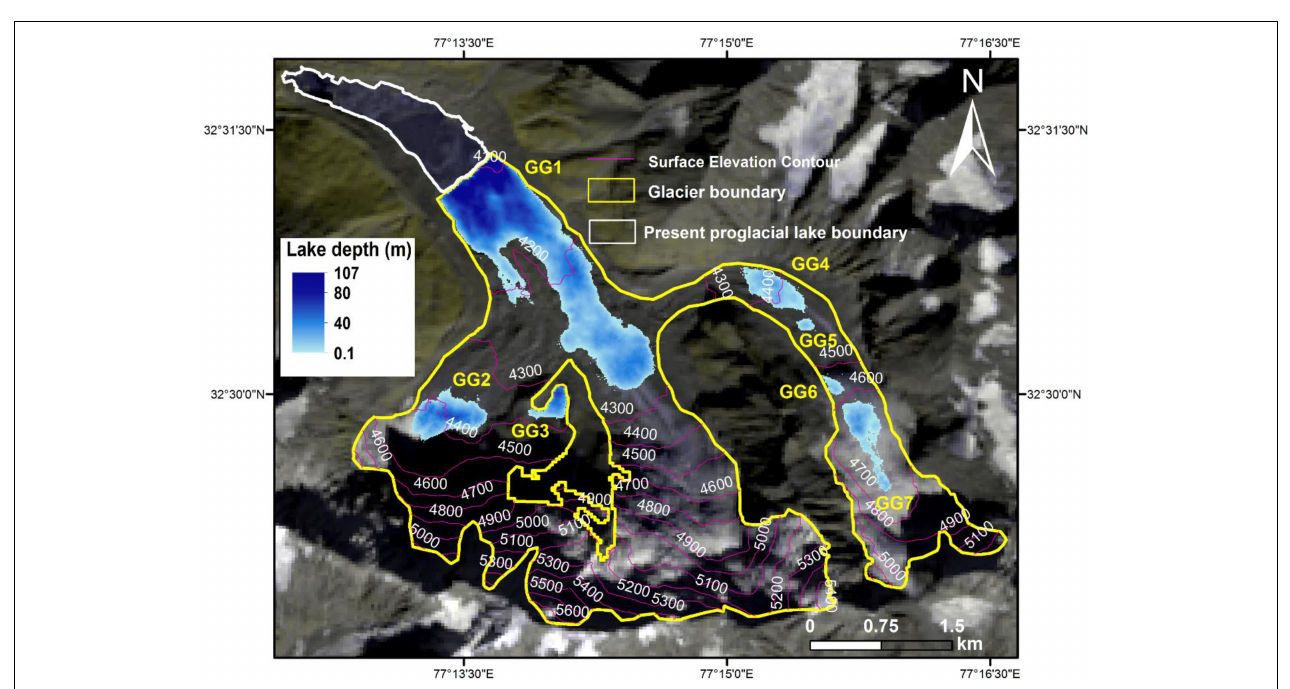
FIGURE 4 | Spatial distribution of the potential sites for future lake formation in the Gepang Gath Glacier obtained based on TDX DEM.